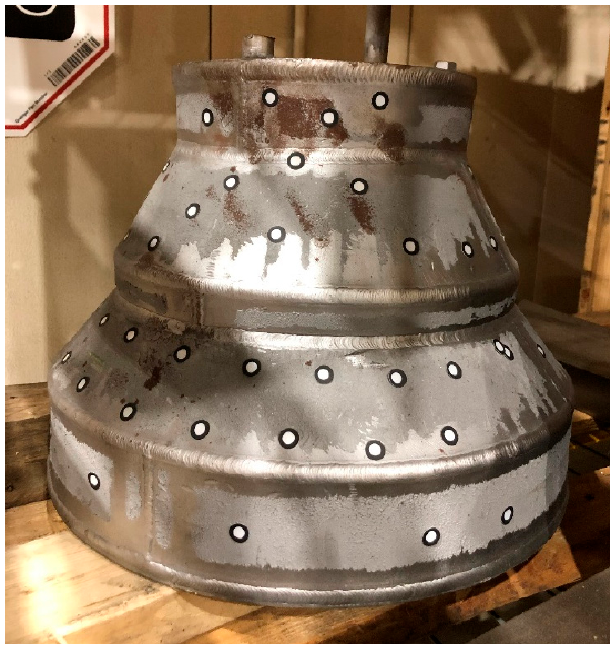
Figure 15. Experimental capsule post-HIP (dots for 3D scanning). Table 3. Final